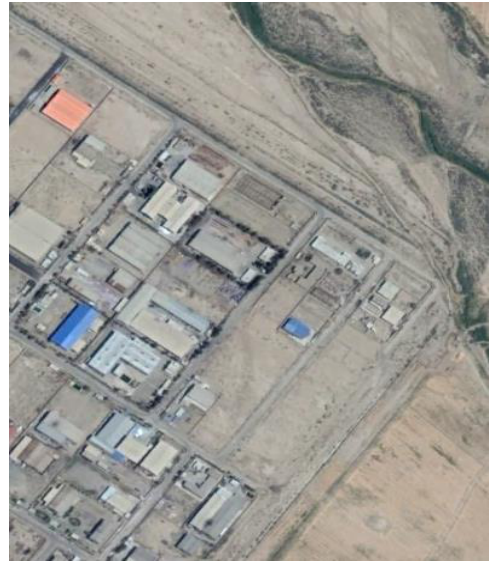
Figure 1. Study area located in Charmshahr The sensor used in this research is a thermal camera that can be installed on the UAV system. In this research, thermal video was taken from the target area. The camera is installed